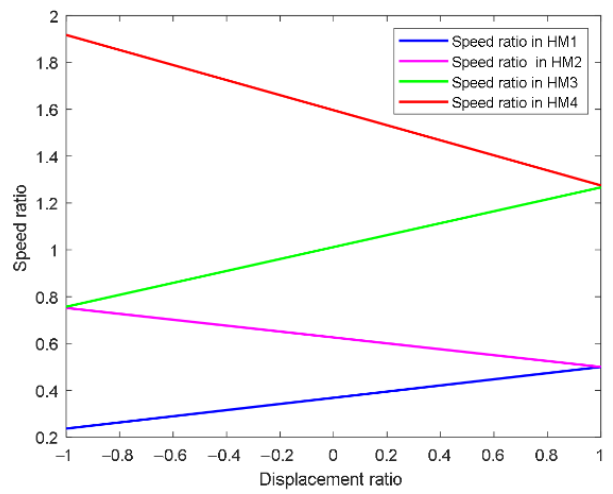
Figure 7. Speed regulation characteristics in hydro-mechanical stages of HMCVT.